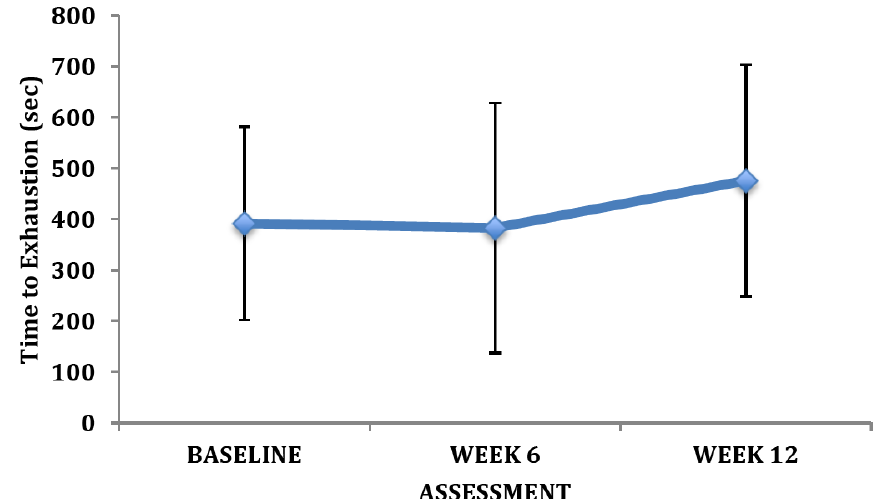
Figure 4. Changes in time to exhaustion with training (mean ±